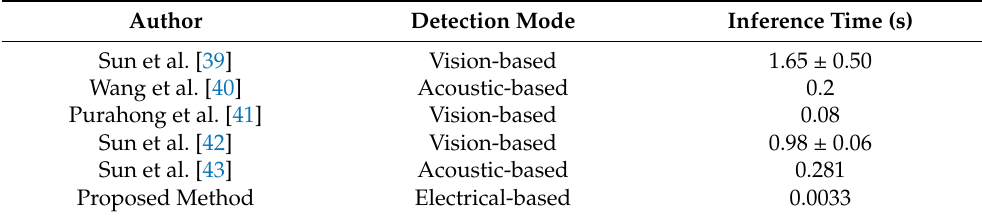
Table 3. Comparison of inference time between the proposed method and other crack detection tech-